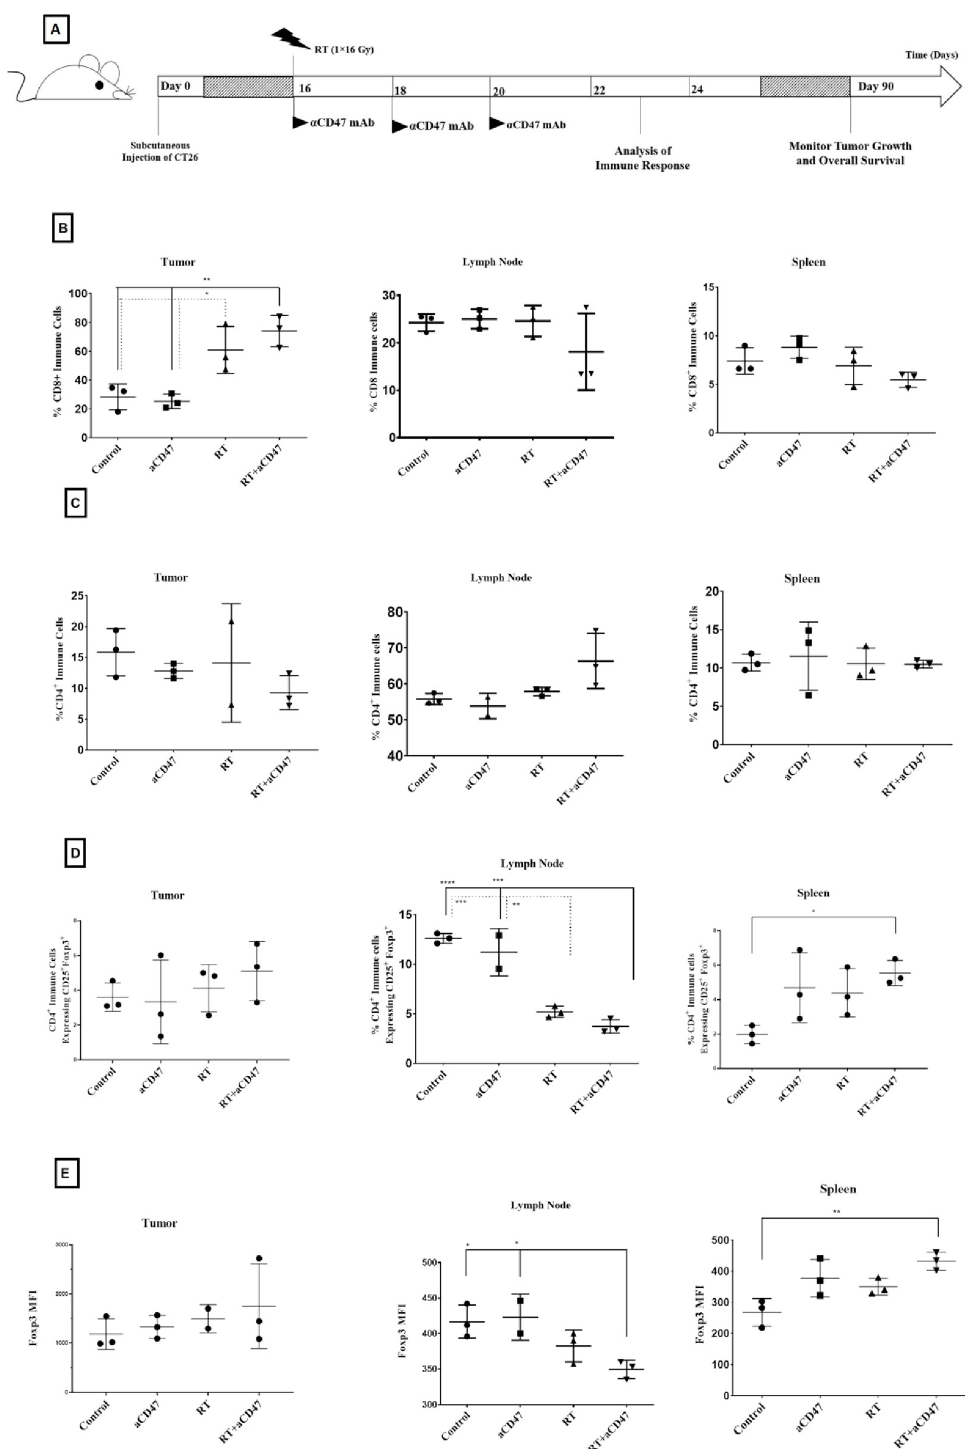
Fig 2. CD8+ cell infiltration increased due to combination of ablative RT and α CD47 mAb in tumors. The schematic plan of combining ablative RT with α CD47 mAb is shown, combining ablative RT with α CD47 mAb (n = 9), RT (n = 9), α CD47 (n = 8), and the control (n = 9). Tumor induction was completed with 1 × 10 6 CT26 cells inoculated into the right flanks of the mice subcutaneously. Tumor induction day as the first day of study. On day 16, RT was performed (1 × 16Gy). On day 23, 3 mice of each group were analyzed by flow cytometry. In combining RT and α CD47 mAb groups,